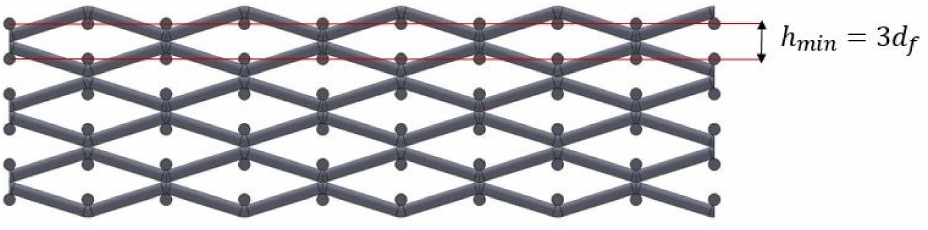
Figure 5. Front view of inline stacking type-b for closely packed scenario (with h min